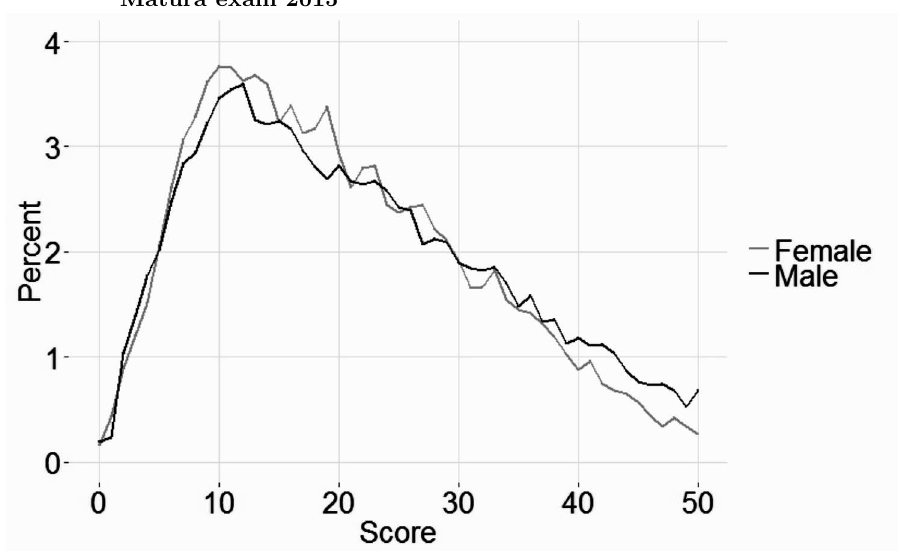
Figure 3. Percentage of male and female on a given score level in advanced Matura exam